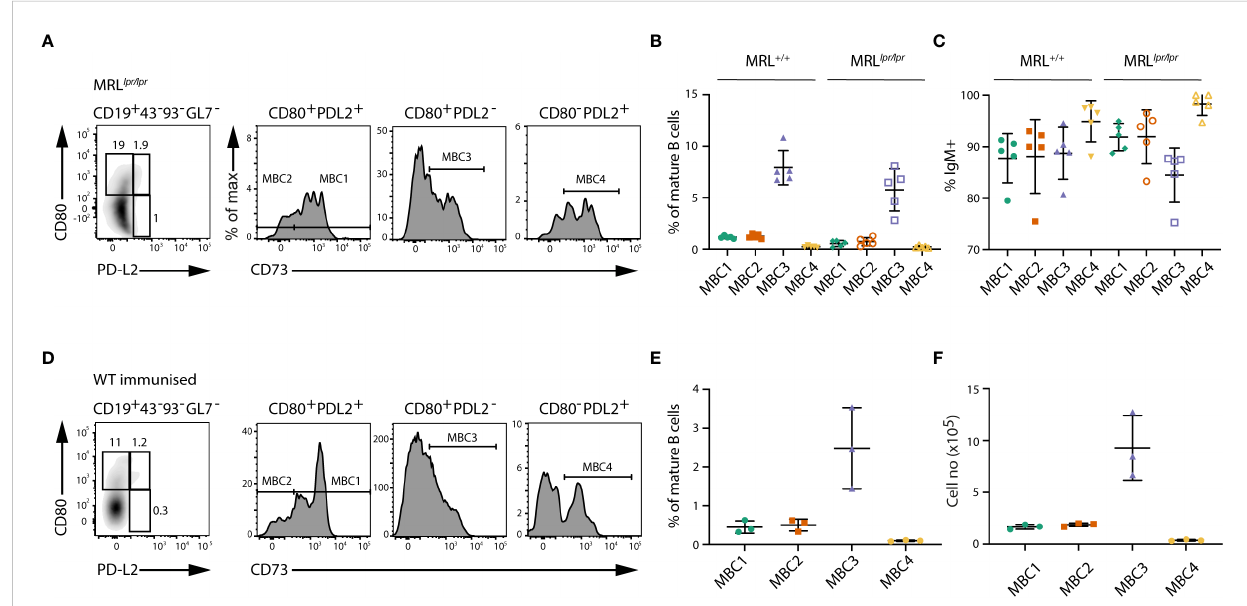
FIGURE 2 Phenotypic characterisation of MBC subsets in MRL lpr/lpr mice and WT immunised mice. (A) FACS plots show the different MBC subsets in MRL lpr/lpr mice. Cells are gated on CD19 + CD43 - CD93 - GL7 - mature B cells and then using CD73, CD80 and PD-L2 for detection of MBCs as in Figure 1. (B) Graph shows the proportions of MBC1-4 in MRL +/+ and MRL lpr/lpr mice. (C) Graph shows the proportions of IgM-expressing cells within MBC1-4 subsets in MRL +/+ and MRL lpr/lpr mice. (D) FACS plots show the different MBC subsets in SRBC-immunised WT mice fi ve months after booster dose. (E, F) Graph shows the proportions (E) and absolute numbers (F) of MBC1-4 in SRBC-immunised WT mice fi ve months after booster. Results in (A – C) are representative from two independent experiments with n=4-5 in each experiment. Results in (D – F) are representative from two independent experiments with n=3 in each